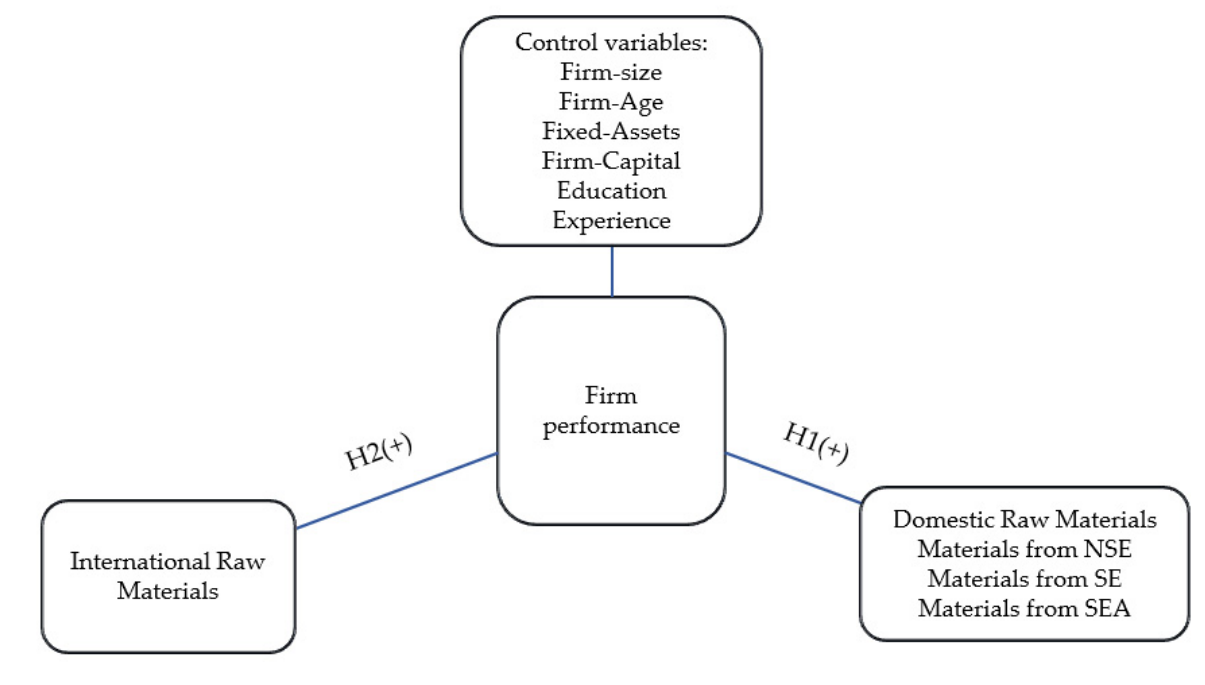
Figure 1. Research